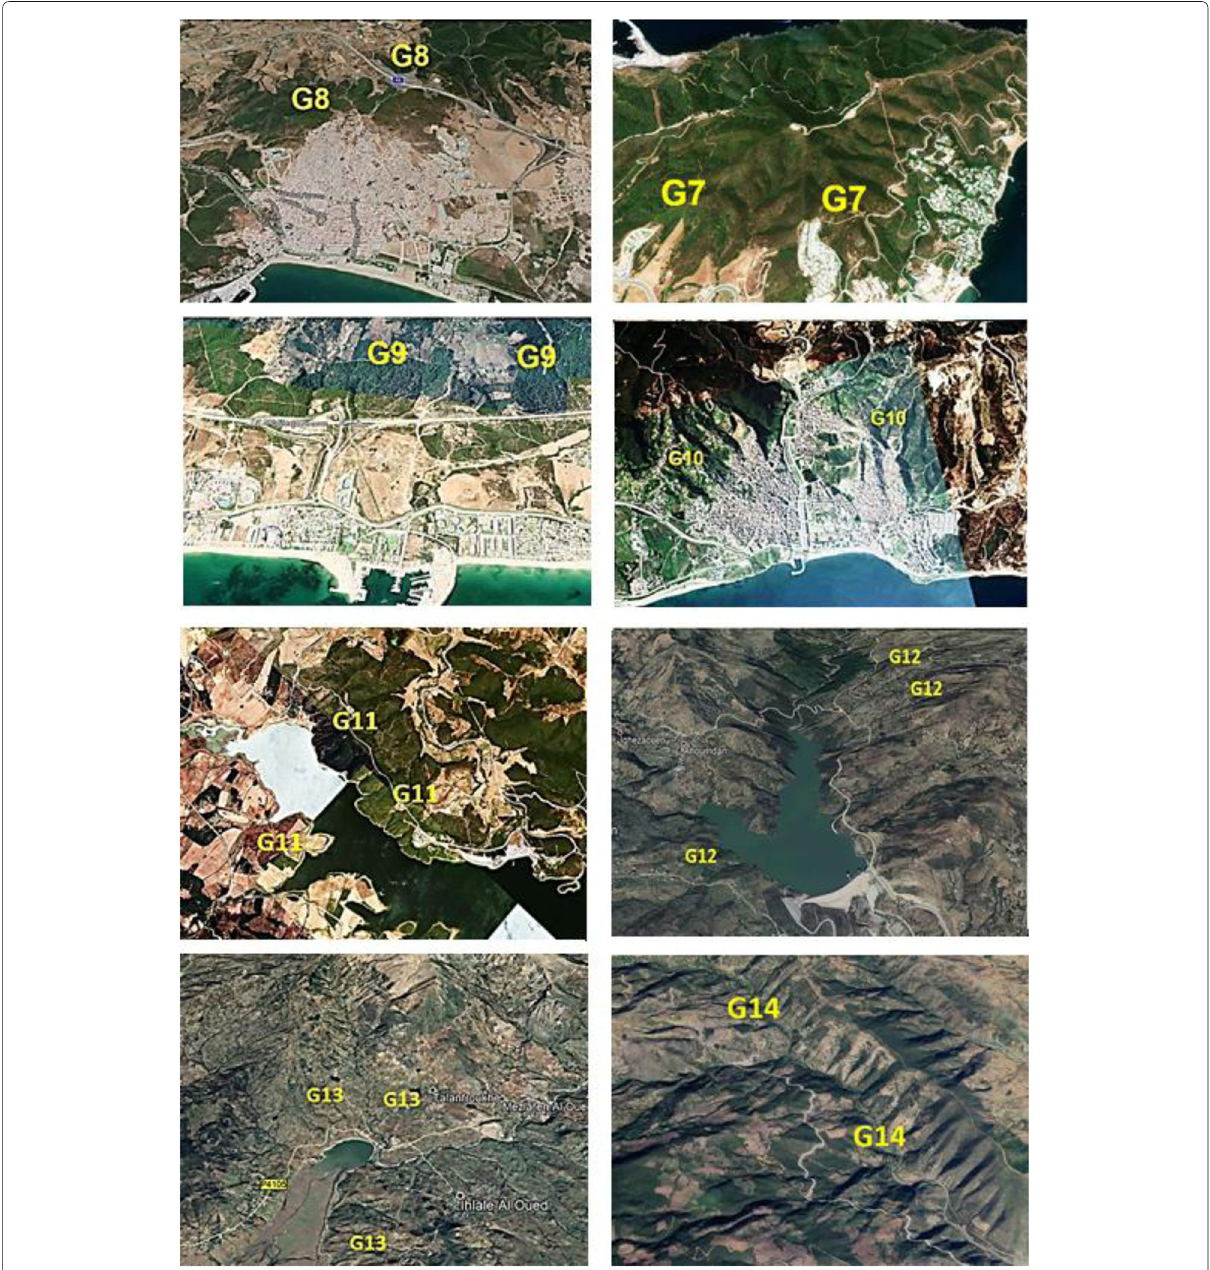
Fig. 11 Examples of Vulnerability to Mass Movements (G) of Urban and Rural Centres, Tourist Complexes (Kabila, Ksar Rimal, Marine Asmir), Ports (Mdik, Marine Asmir) and Important Infrastructure (Dams, ports, highways, national roads) - G7: Cabo Negro Tourist Complex, G8: Mdiq (A6 motorway, and urban centre), G9: Jbel Zem-Zem (auto-road A6), G10: Fnideq (Urban extension on unstable areas,G11: Semsa dam, G12: My Bouchta dam, RN13, P4704; G13: Oued Laou Dam, Route P4105; G14: Idrene